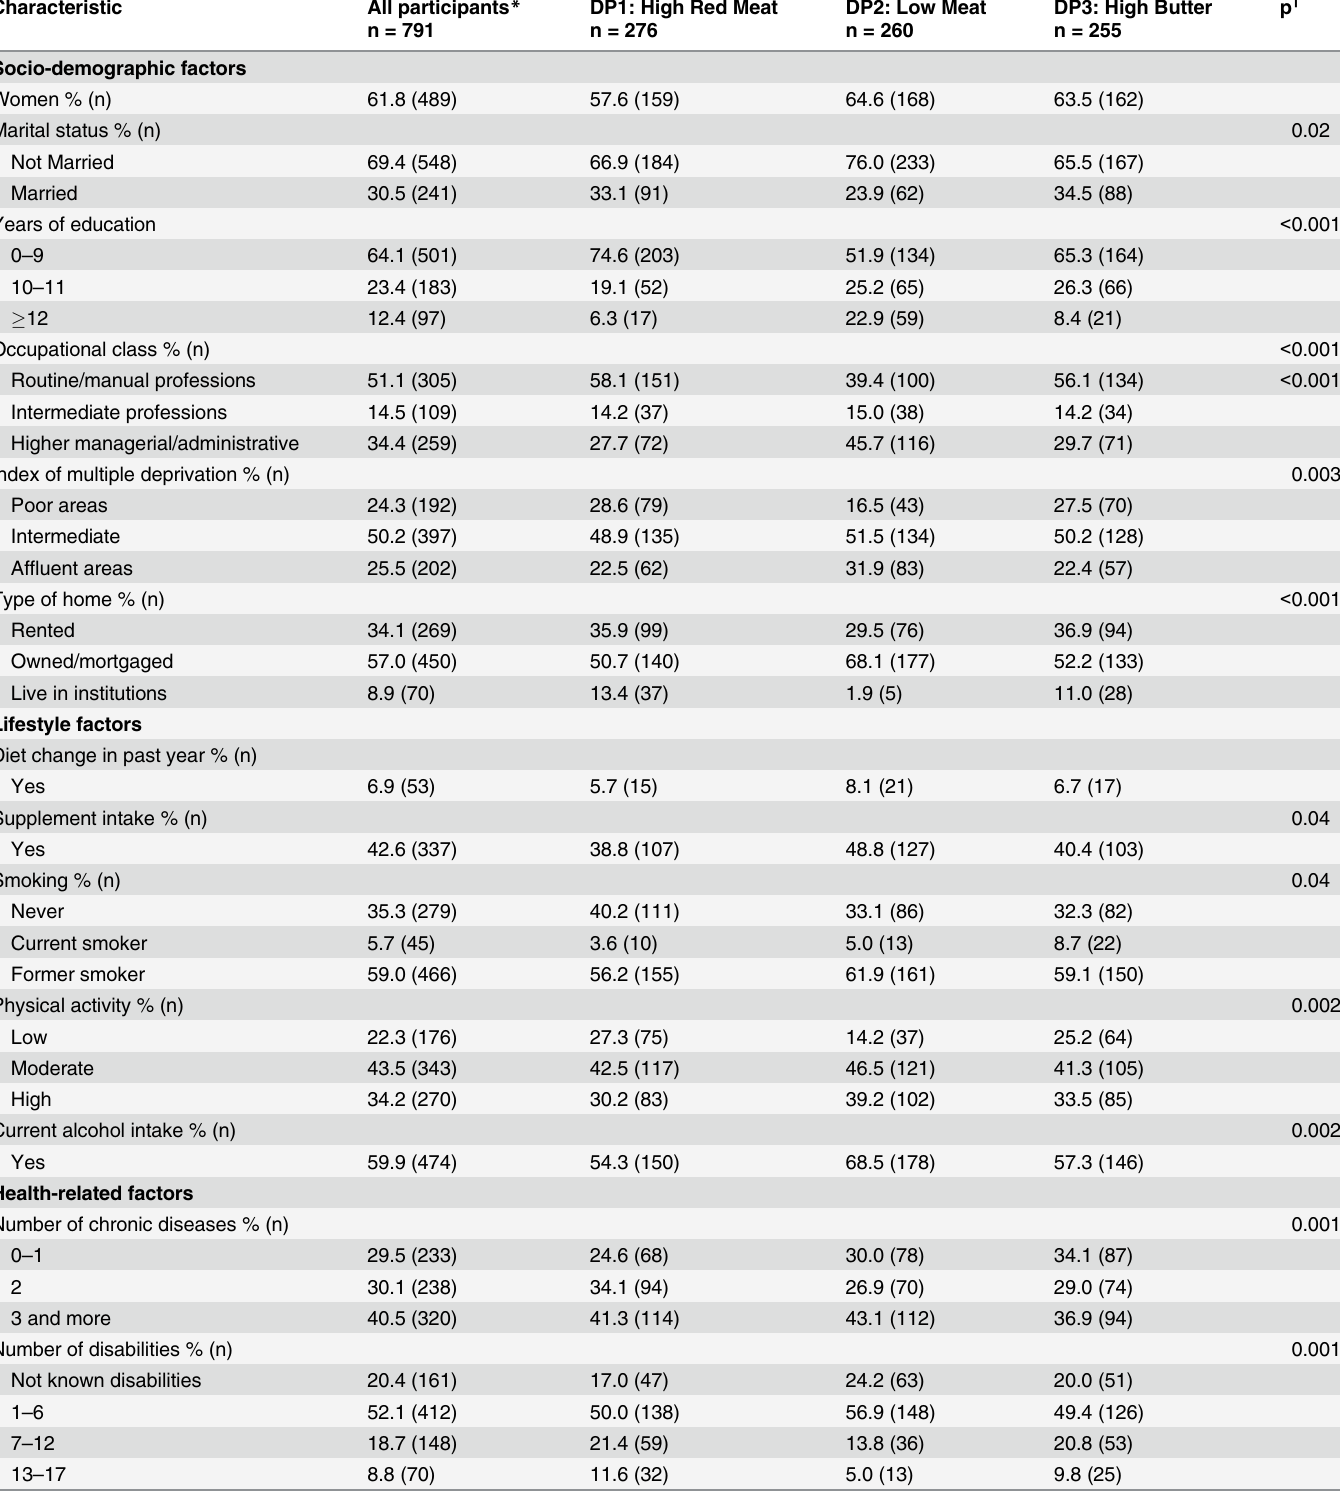
Table 4. Baseline characteristics of study participants by dietary